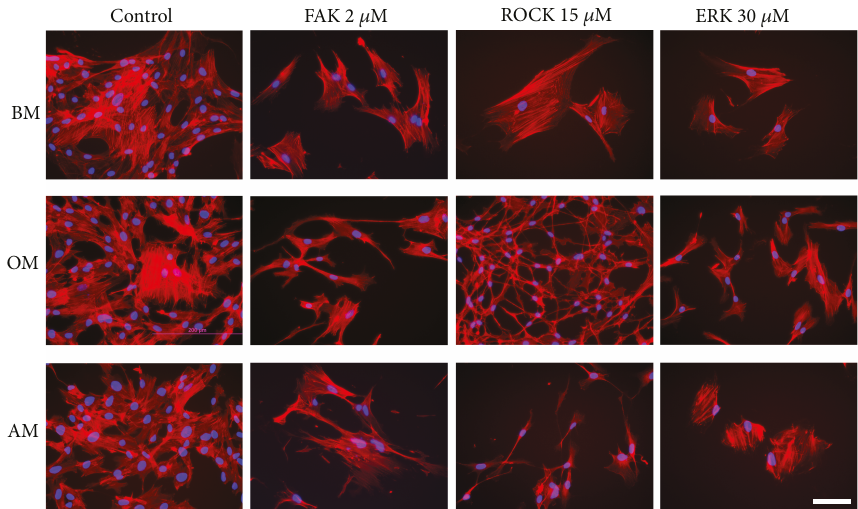
Figure 2: Immuno fl uorescence staining of actin cytoskeleton and nuclei. hASCs were treated with 2 μ M FAK, 15 μ M ROCK, or 30 μ M ERK inhibitors, and the cytoskeleton was stained with phalloidin (red) and nuclei with DAPI (blue) at day 7. Scale bar 100 μ m. BM: basic medium; OM: osteogenic medium; AM: adipogenic